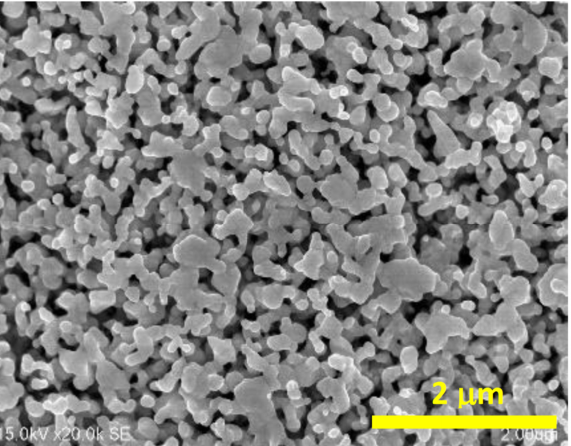
Figure 11. Scanning Electron Microscopy image of the nanostructured silver electrode.